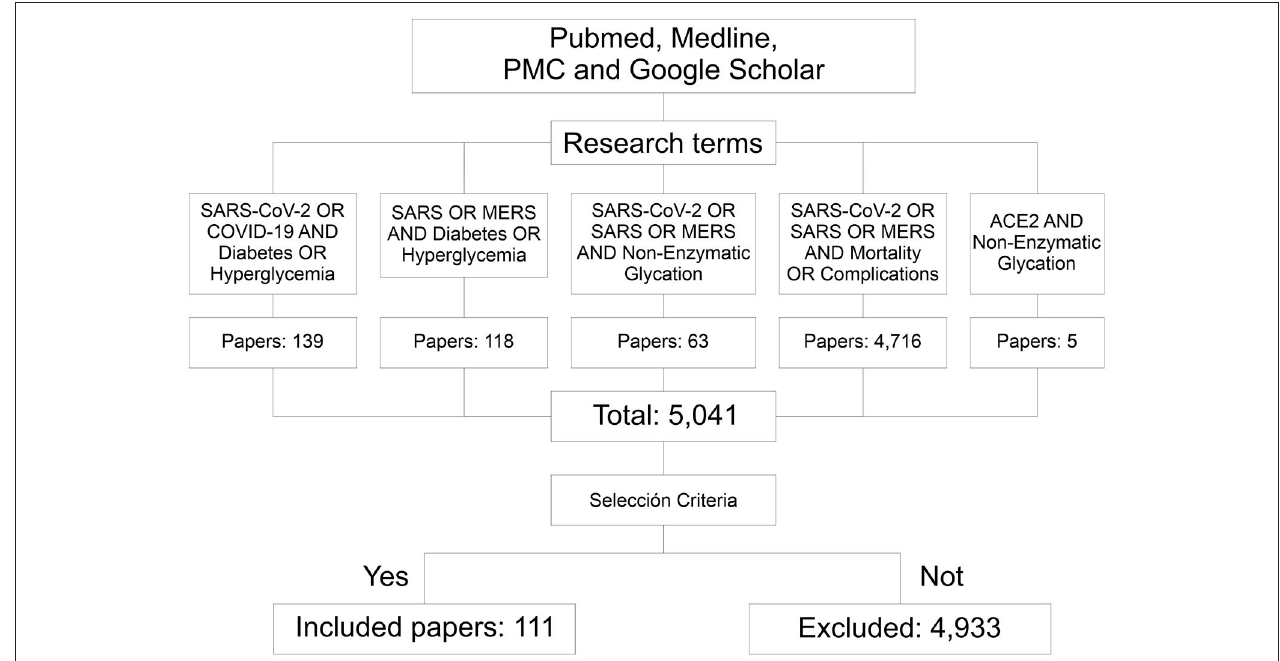
FIGURE 1 | Flowchart of the information searching method. Through the research terms 5,041 papers related to this topic were identified. According to the inclusion criteria, 111 of them were considered for this documentary research. PMC, PubMed central; SARS, severe acute respiratory syndrome; CoV, coronavirus; MERS, meddle east respiratory syndrome.